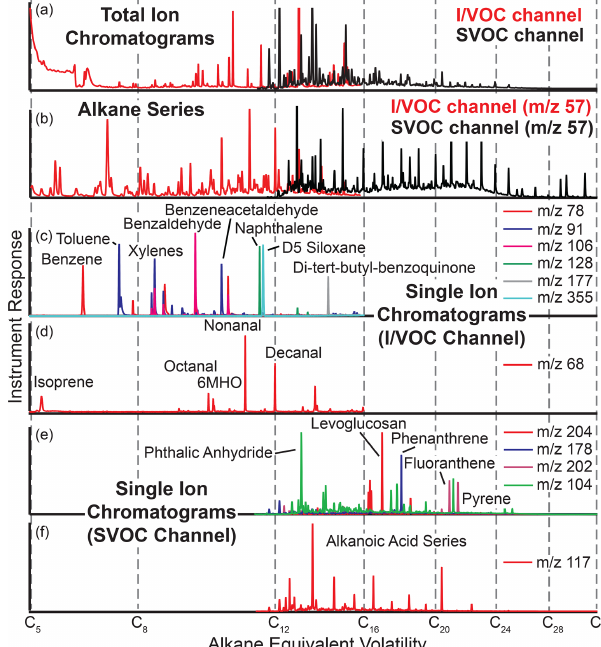
Figure 7. Example chromatograms from cTAG. Panels (a) and (b) from FIREX-AQ 2019 in McCall, Idaho, demonstrate the range of volatility covered by the two channels, including their overlap re- gion. Single ion chromatograms (panels c , d and f from Berkeley, California, and e from Livermore, California) show examples of the compound classes observable by cTAG, including aromatics, poly- cyclic aromatic hydrocarbons, organic acids and anhydrosugars.